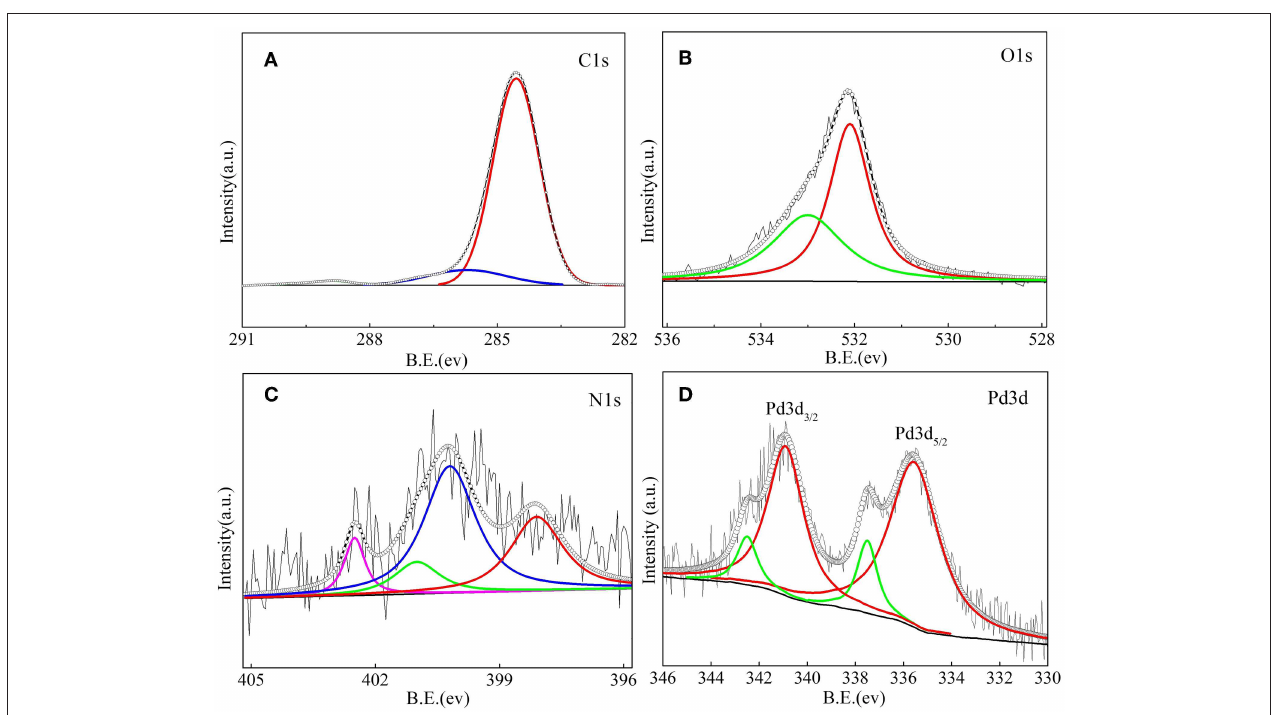
FIGURE 7 | XPS of the C 1s core level (A) , O 1s core level (B) N 1s core level (C) and Pd 3d core level (D) of the 1Pd/NOMC − 0.3–750 nanostructured material.